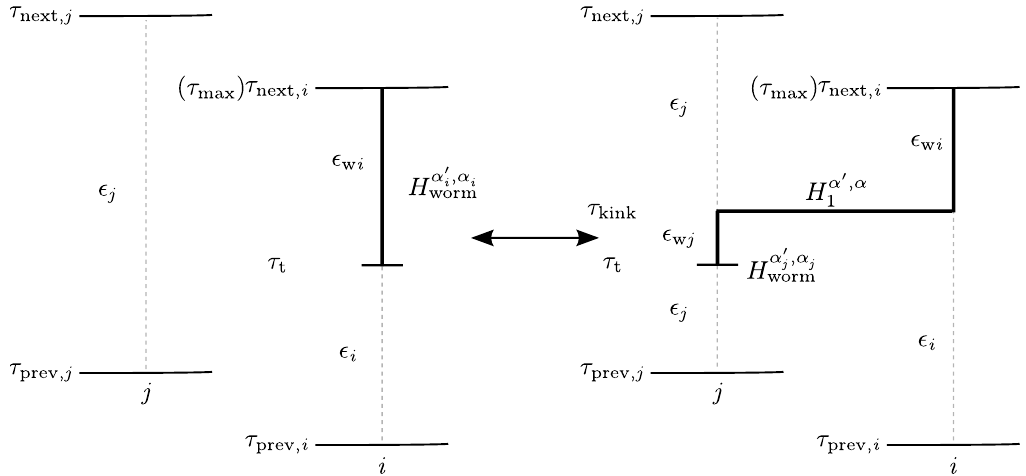
∈ [ τ ) and the tail , τ kink t max